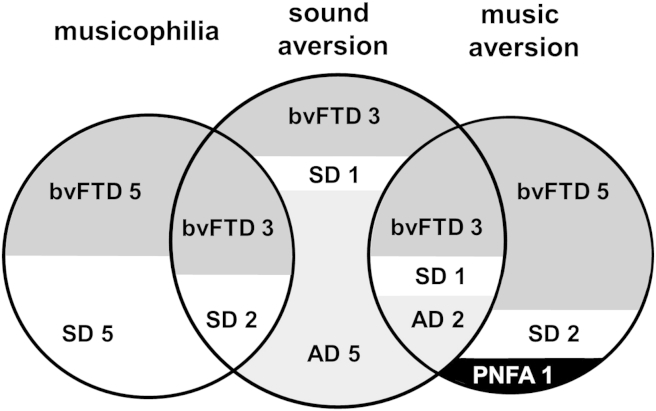
Diagrammatic breakdown of auditory hedonic symptoms across the patient cohort. Case numbers in each symptom category are indicated. Key: AD, syndrome of Alzheimer's disease led by decline in episodic memory (light grey); bvFTD, behavioural variant of frontotemporal dementia (dark grey); PNFA, progressive nonfluent aphasia (black); SD, semantic dementia (white).